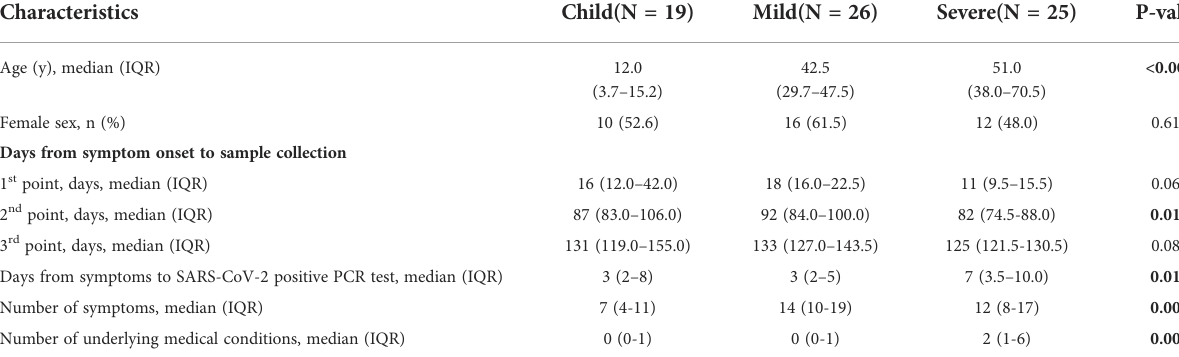
TABLE 1 Clinical characteristics of patients.